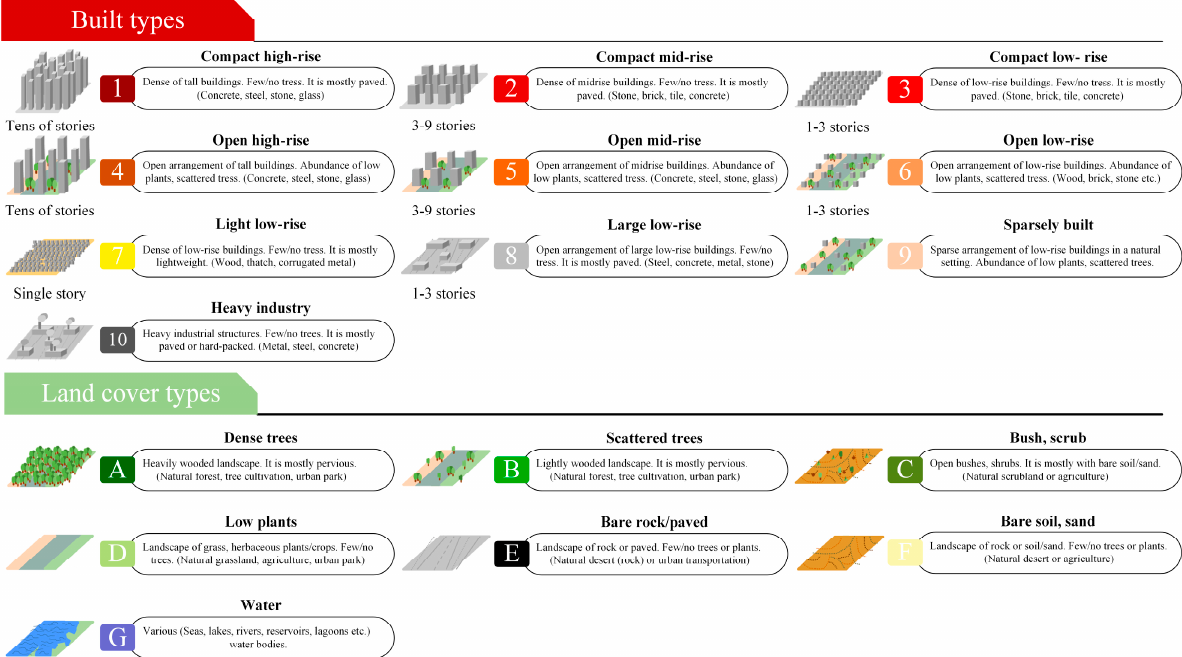
Figure 1. The LCZ system and related definitions from Stewart and Oke [9,11]. The contents in brackets are the common materials or landscapes for diverse LCZs.